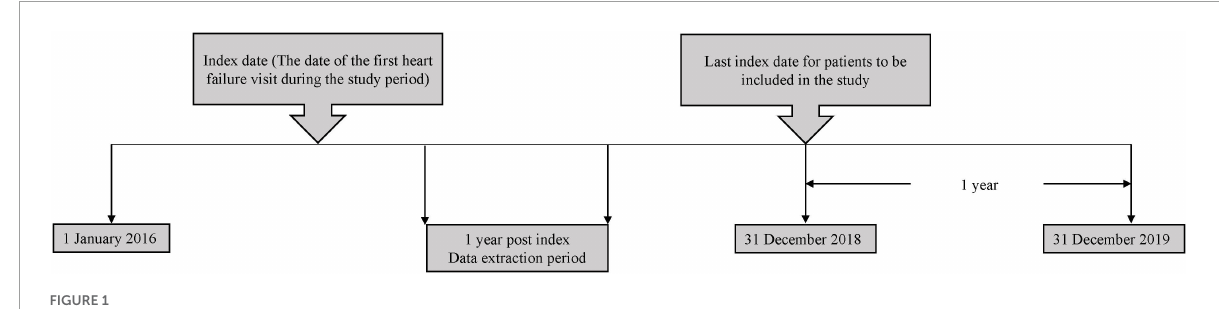
FIGURE1 Study design.